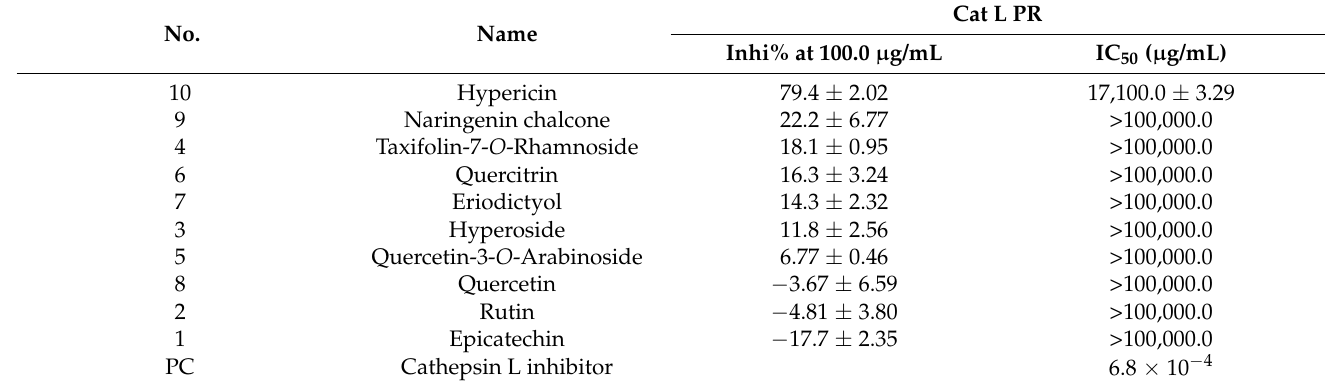
Table 4. Inhibition of Cat L PR by the 10 active compounds in H. kouytchense insect gall extracts ( n = 3).